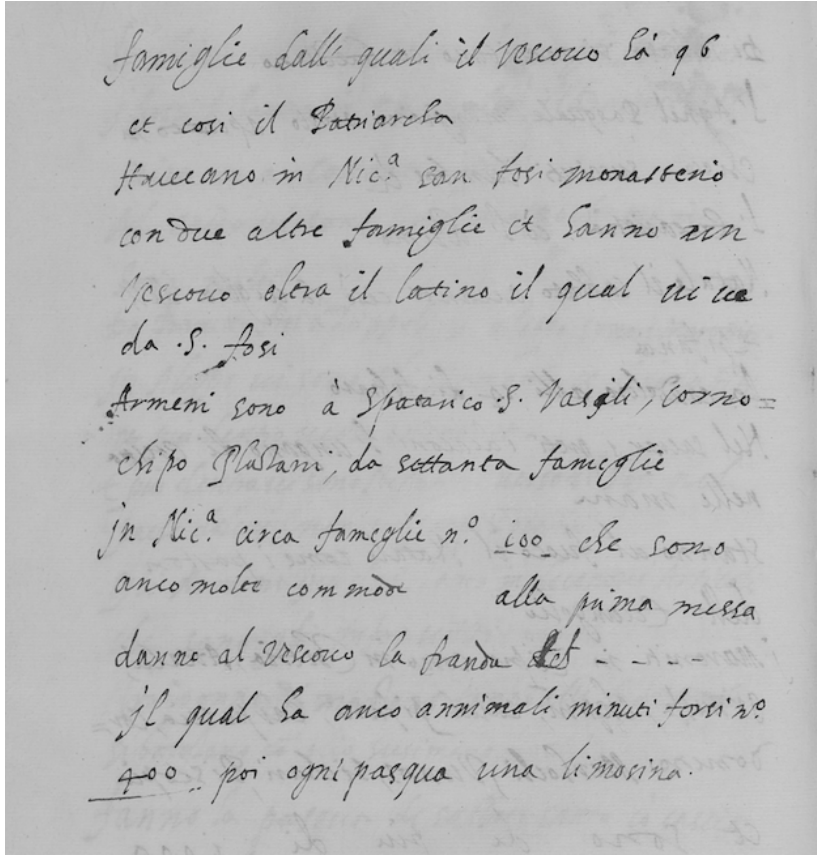
Figure 3. Codex Bank of Cyprus Cultural Foundation B-030, f. 37 v , mentioning (in line 3) the Maronite monastery of San Fosi , which may be referring to Ayios Iakovos.